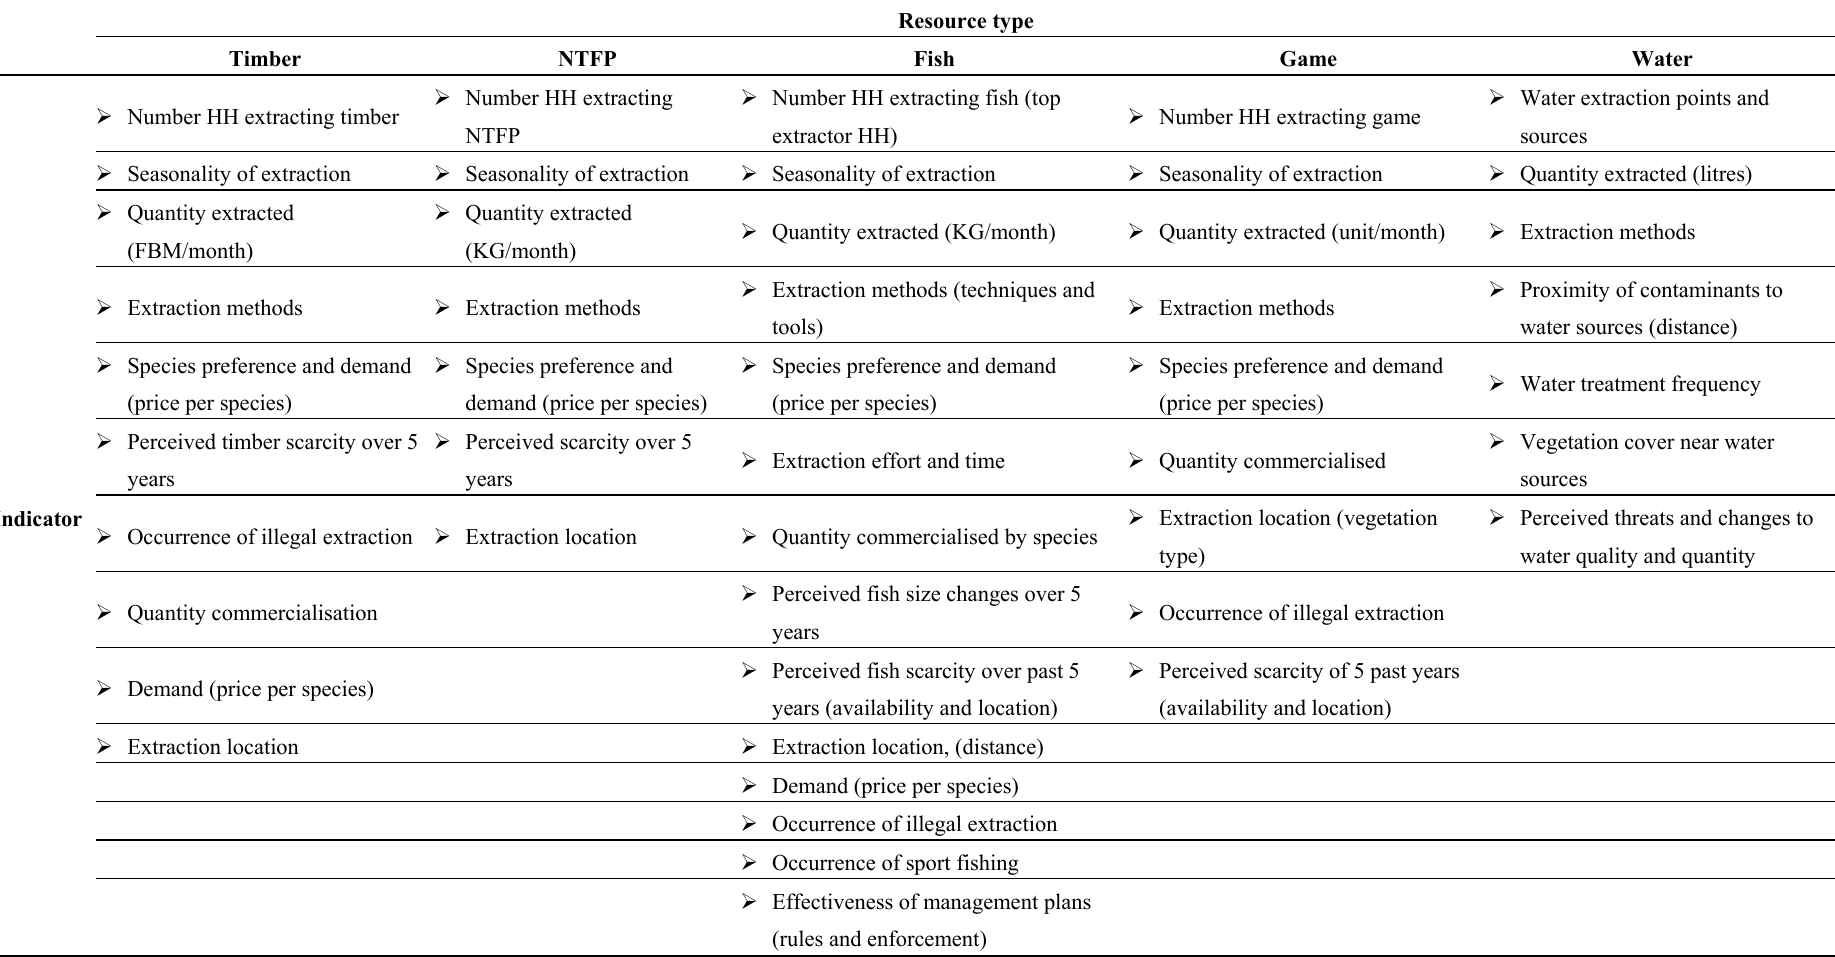
Table 1. Sustainability indicators for natural resource